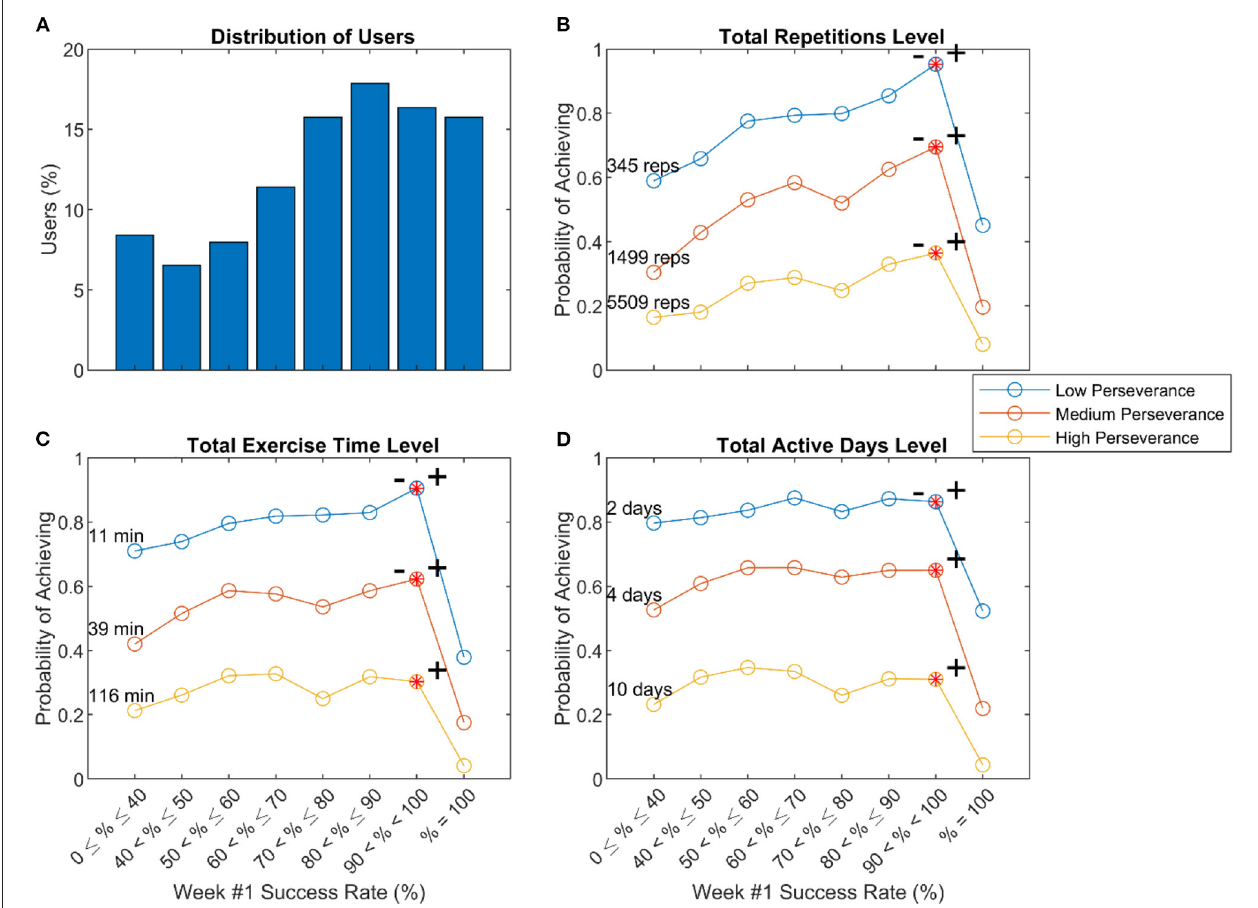
FIGURE 7 | Relationship of initial success and perseverance. (A) Distribution of users with various success levels in leveling up during Week #1 (B–D) Probability of achieving low, medium, and high levels of perseverance, defined to be the 25th, 50th, and 75th percentiles of three measures of usage – total repetitions (B) , total exercise time (C) , and total active days (D) – measured across 8 weeks of use. The – and symbols indicated significant declines to left and right, respectively, from + the peak value using the “sweet spot” test described in the methods ( p < 0.05).